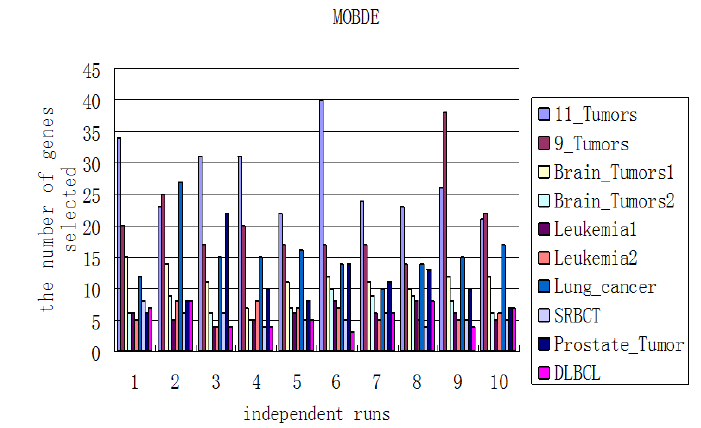
Figure 3. The number of selected gene obtained by MOBDE in each independent run.